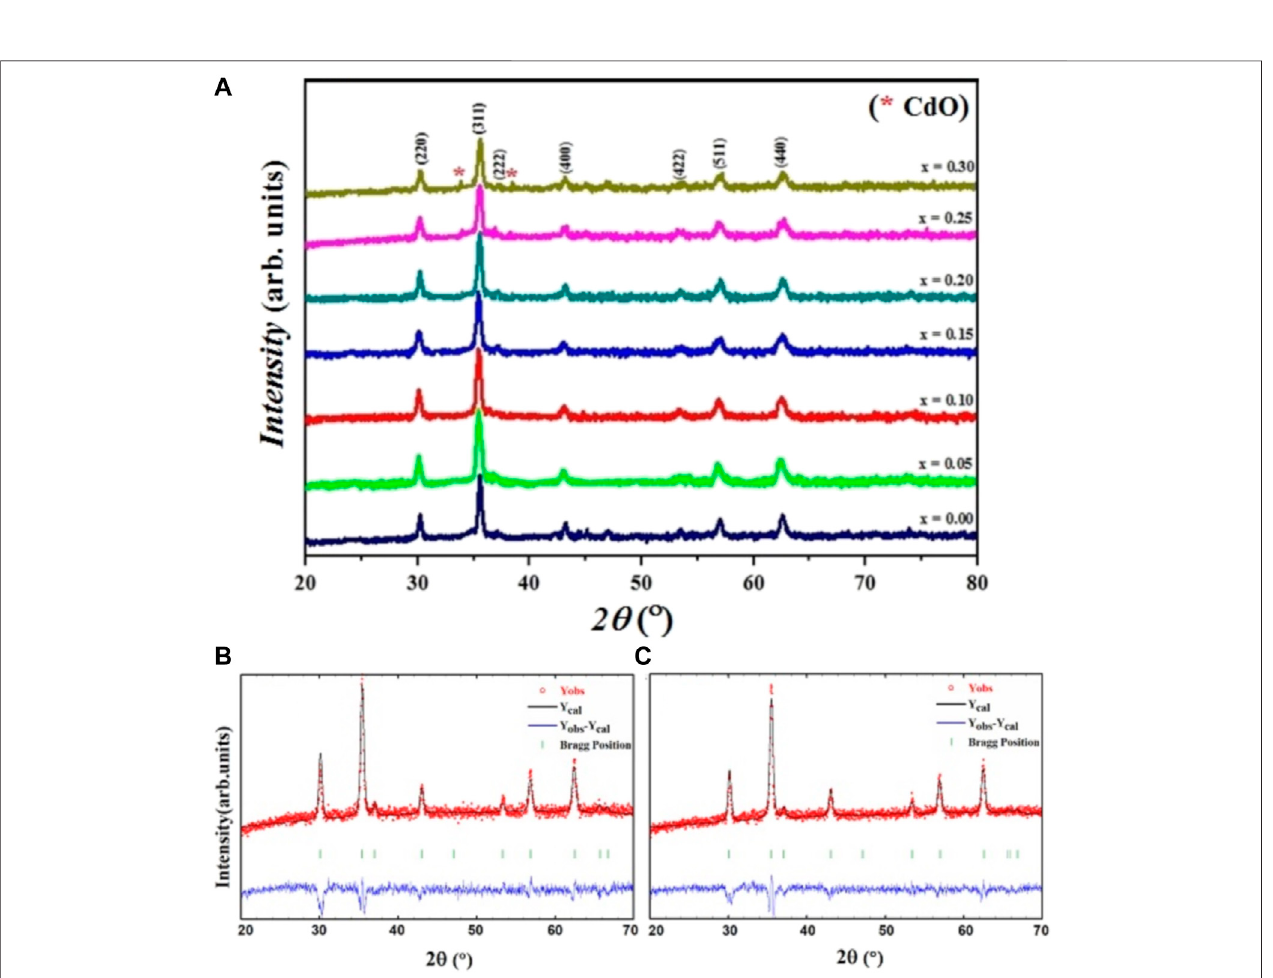
FIGURE 1 | (A) XRD patternsof Cd x Mg 0.3- x Cu 0.2 Zn 0.5 Fe 2 O 4 ferrites. (B) , (C) Rietveld re fi nement of XRD pattern for samples x (cid:1) 0.00, 0.05,